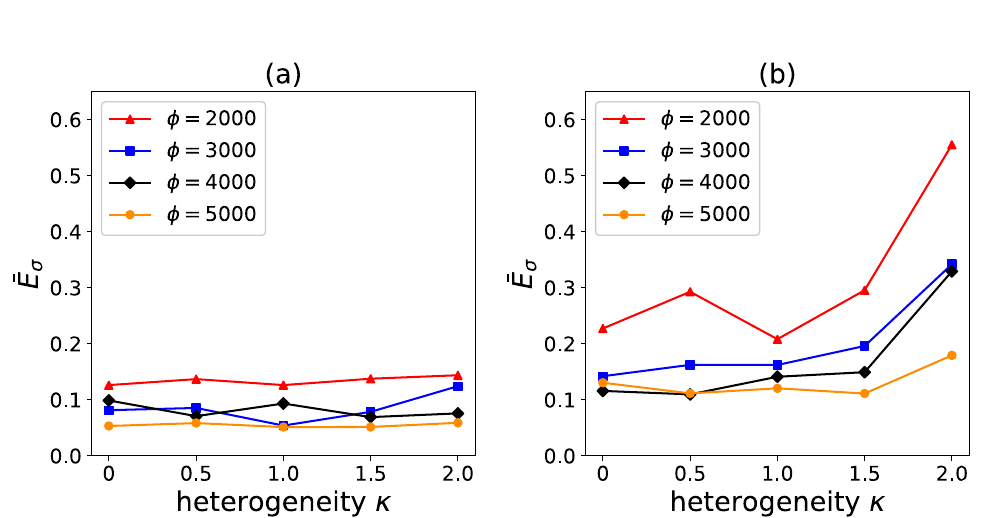
Figure 8. Average path-wise stress error E σ (calculated over 20 different pseudo-random loading paths) as a function of the heterogeneity κ and the number of training data points φ . Data are shown for a viscoelastic model using a single-term Prony series ( a ) or a three-term Prony series ( b